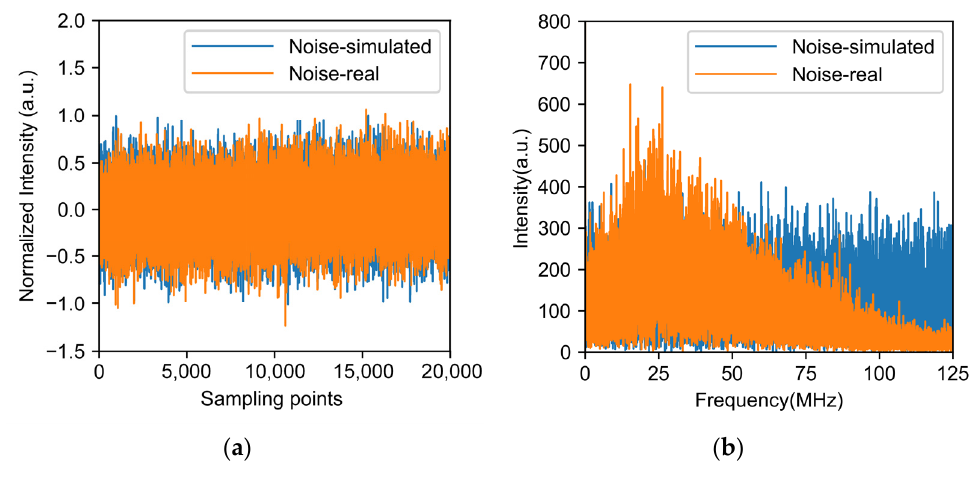
Figure 4. ( a ) Time domain and ( b ) frequency domain of simulated noise and real noise.